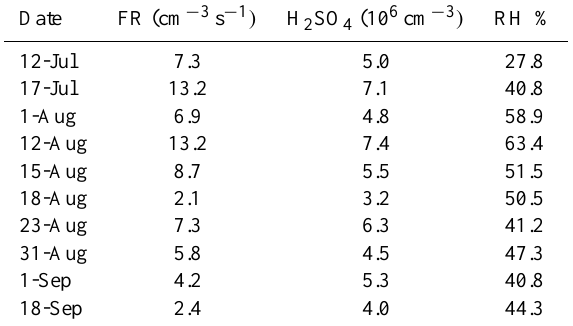
Table 1. Summary of nucleation events during the CAREBeijing 2008 field study including aerosol formation rate (FR), GSA con- centration, and relative humidity (RH%) that used in the multivari- ate analysis to evaluate the number of sulfuric acid molecule in the critical